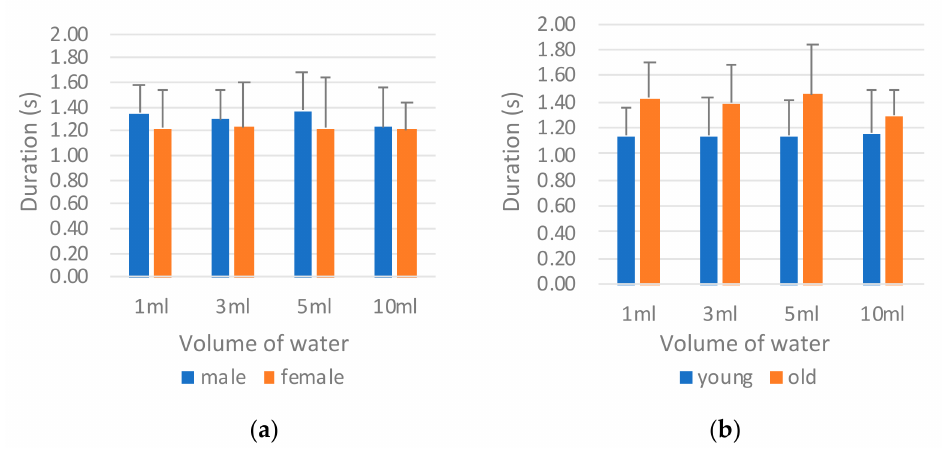
Figure 14. Comparison of tongue pressure onset duration ( T tongue ) by ( a ) sex and ( b ) age. Table 10. Analysis of variance results of tongue pressure onset duration ( T tongue